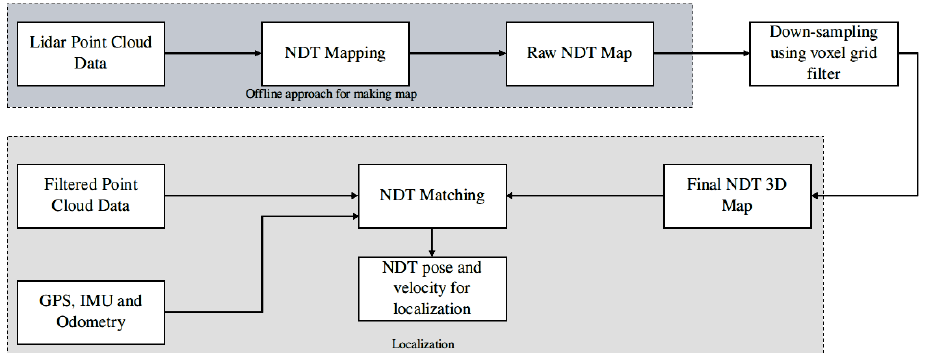
Figure 5. The flow diagram of the localization process is shown. First, the map is built using NDT mapping using the Lidar data. The point cloud data is downsampled using voxel grid filter for the refinement of 3D map. NDT matching takes filtered Lidar data (scans), GPS, IMU, Odometry, and 3D map for the pose estimation.